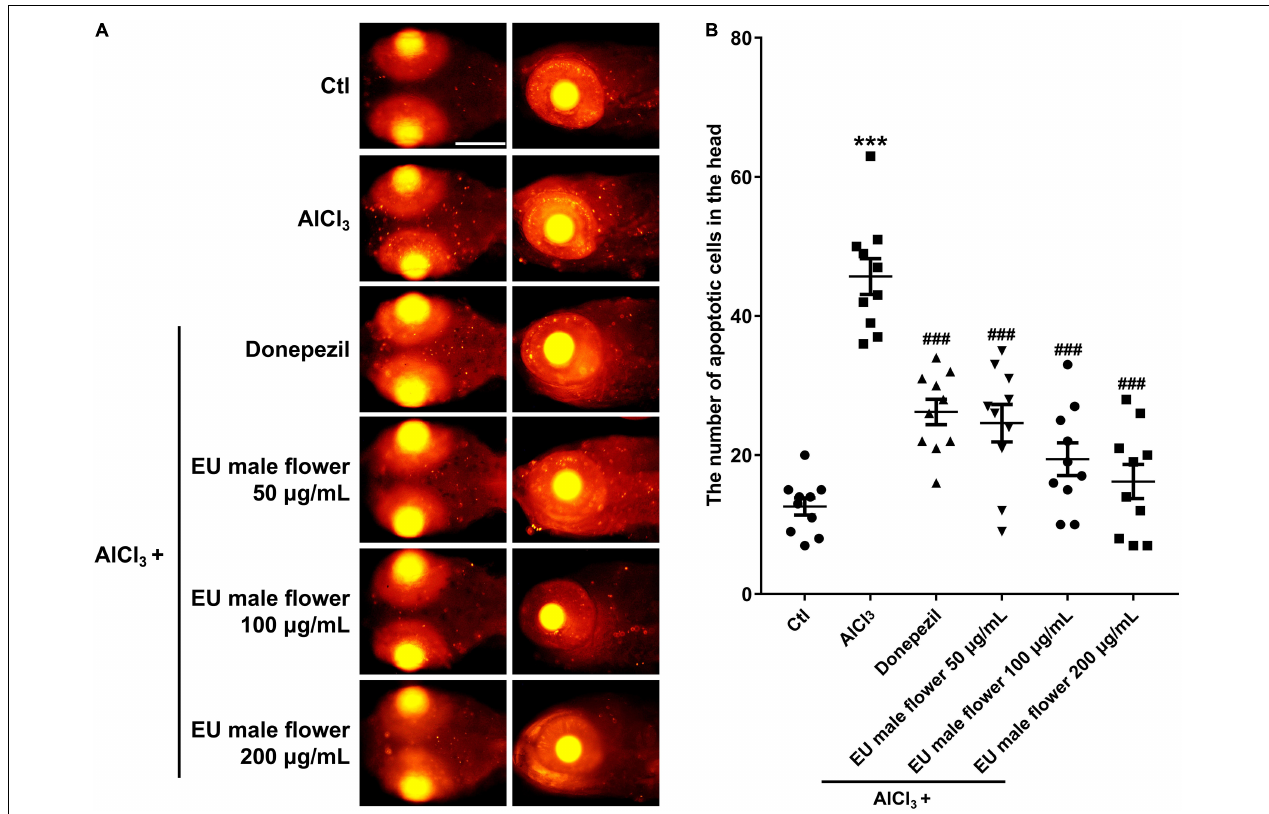
FIGURE 5 | Effect of EUMF on apoptosis in the brains of the AlCl 3 -modeled zebrafish. (A) The apoptotic cells were stained with TUNEL (scale bar = 100 µ m). (B) Statistical analysis of the apoptotic cells count in the larvae heads (*** P < 0.001 vs. Ctl; ### P < 0.001 vs. AlCl 3 ; n =